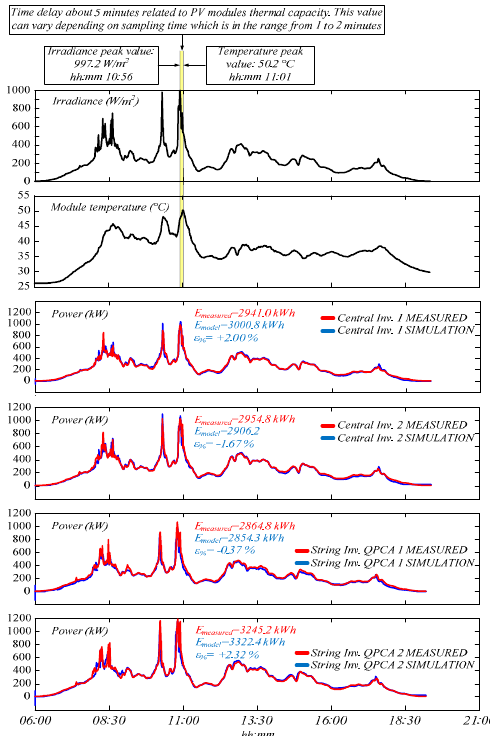
Figure 11. Example of daily power curves measured for each experimental subfield of the PV plant in Brazil. Model output (simulation) vs. measured data. Calculation of percentage relative error.